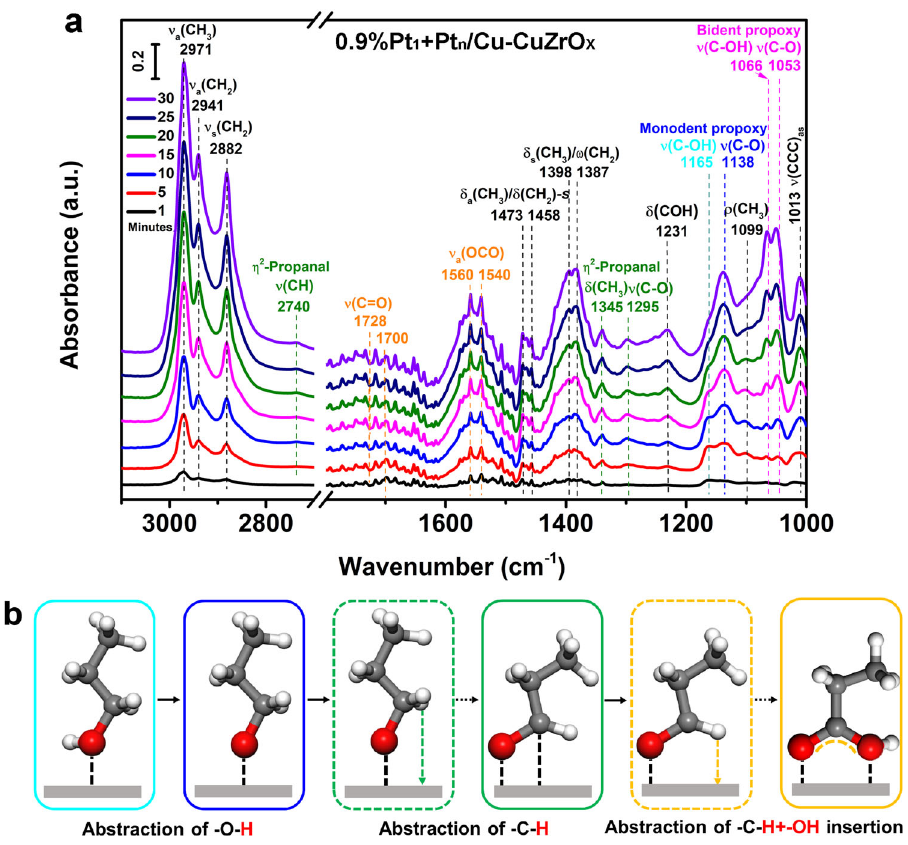
Fig. 8 | Schematic diagram of the reaction pathway during in situ surface reaction. a In situ time-resolved FT-IR spectra of 0.9%Pt 1 +Pt n /Cu-CuZrO x on exposureto1-propanolat60 o CwasrecordedinthepresenceofO 2 andH 2 O.From bottom to top: 1, 5, 10, 15, 20, 25, and 30min. Adsorbates were introduced to the